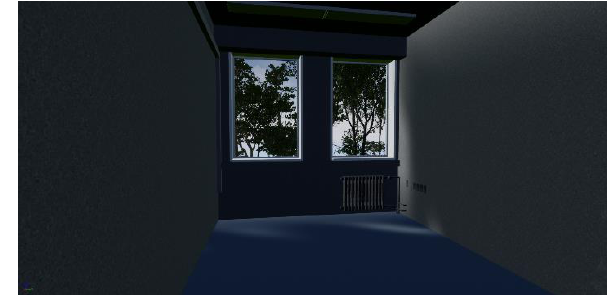
Figure 12. – Hallway in second floor